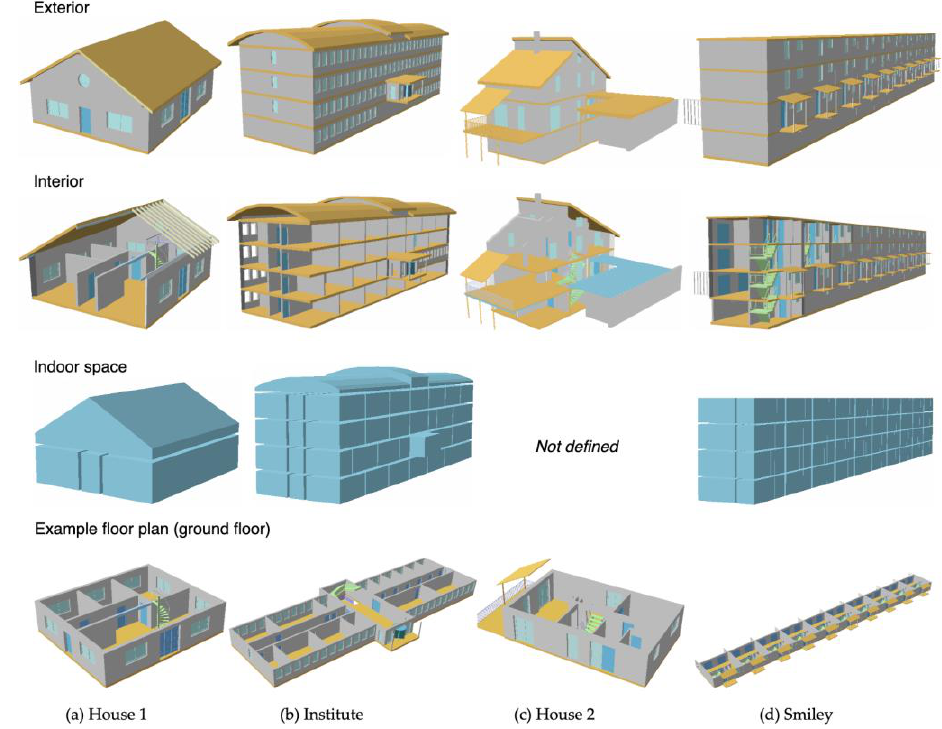
Figure 14. Converted building models, i.e., ( a ) House 1, ( b ) Institute, ( c ) House 2, and ( d ) Smiley.